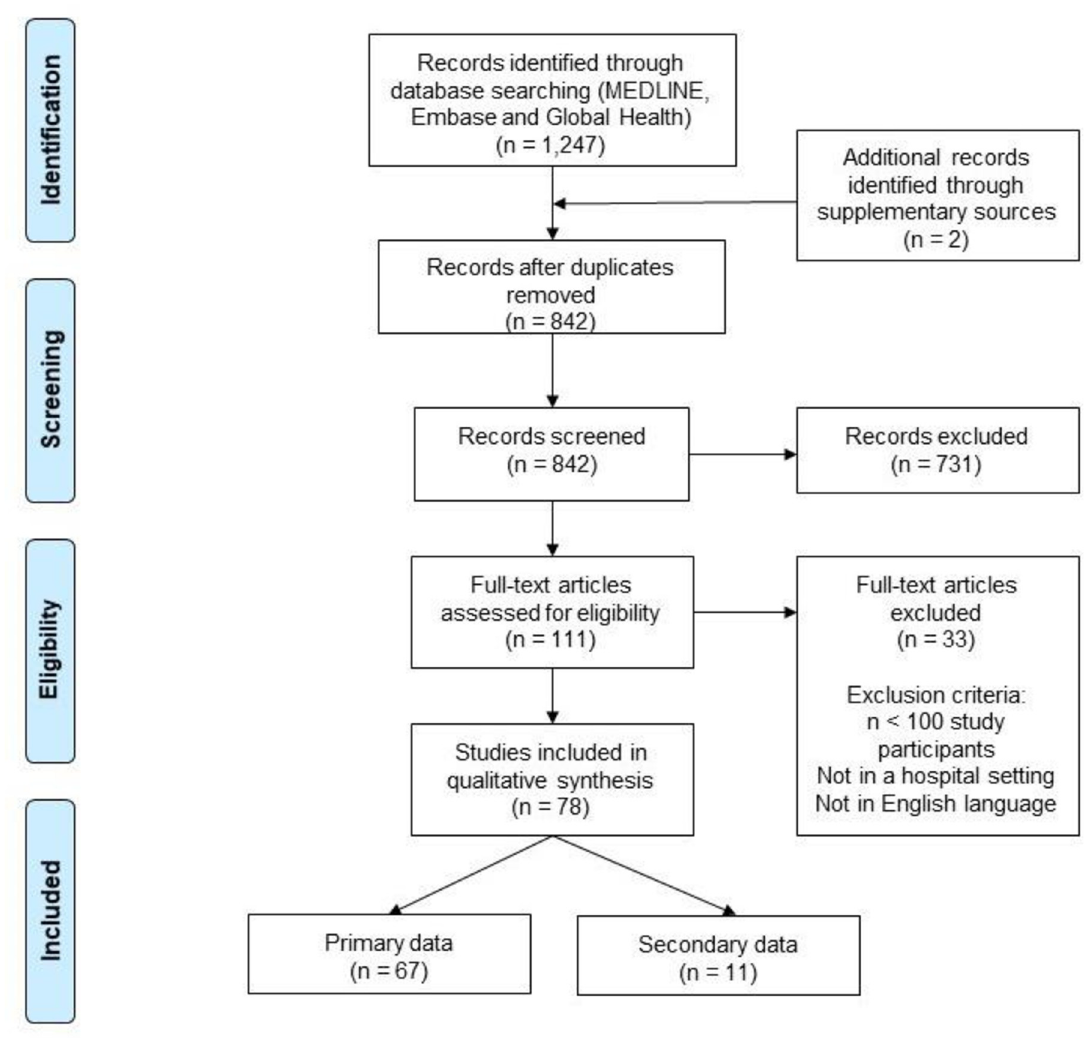
Fig 1. PRISMA diagram for study selection (PRISMA: Preferred Reporting for Systematic Reviews and Meta-Analysis).